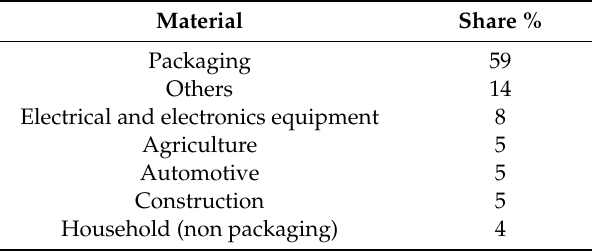
Table 1. Plastic waste generation in Europe in 2015